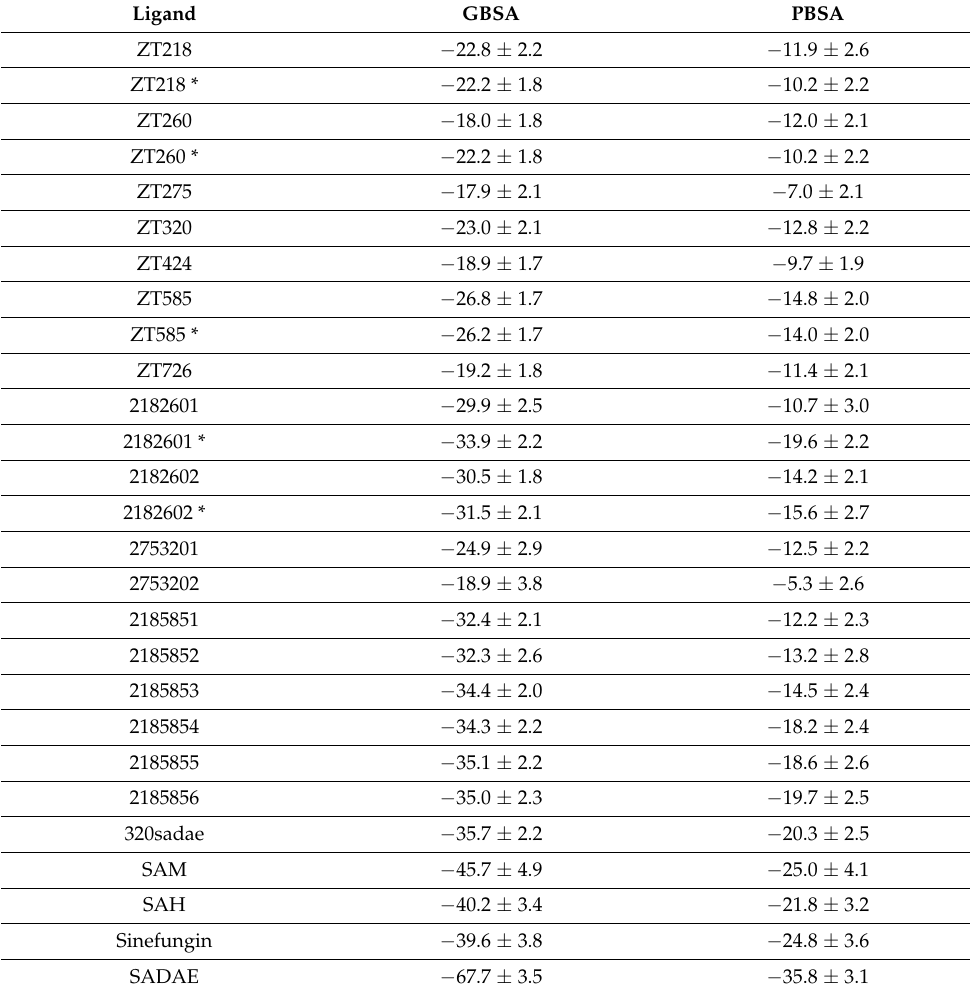
Table 2. Estimated binding energies and standard deviations (kcal/mol) for all ligands mentioned in this